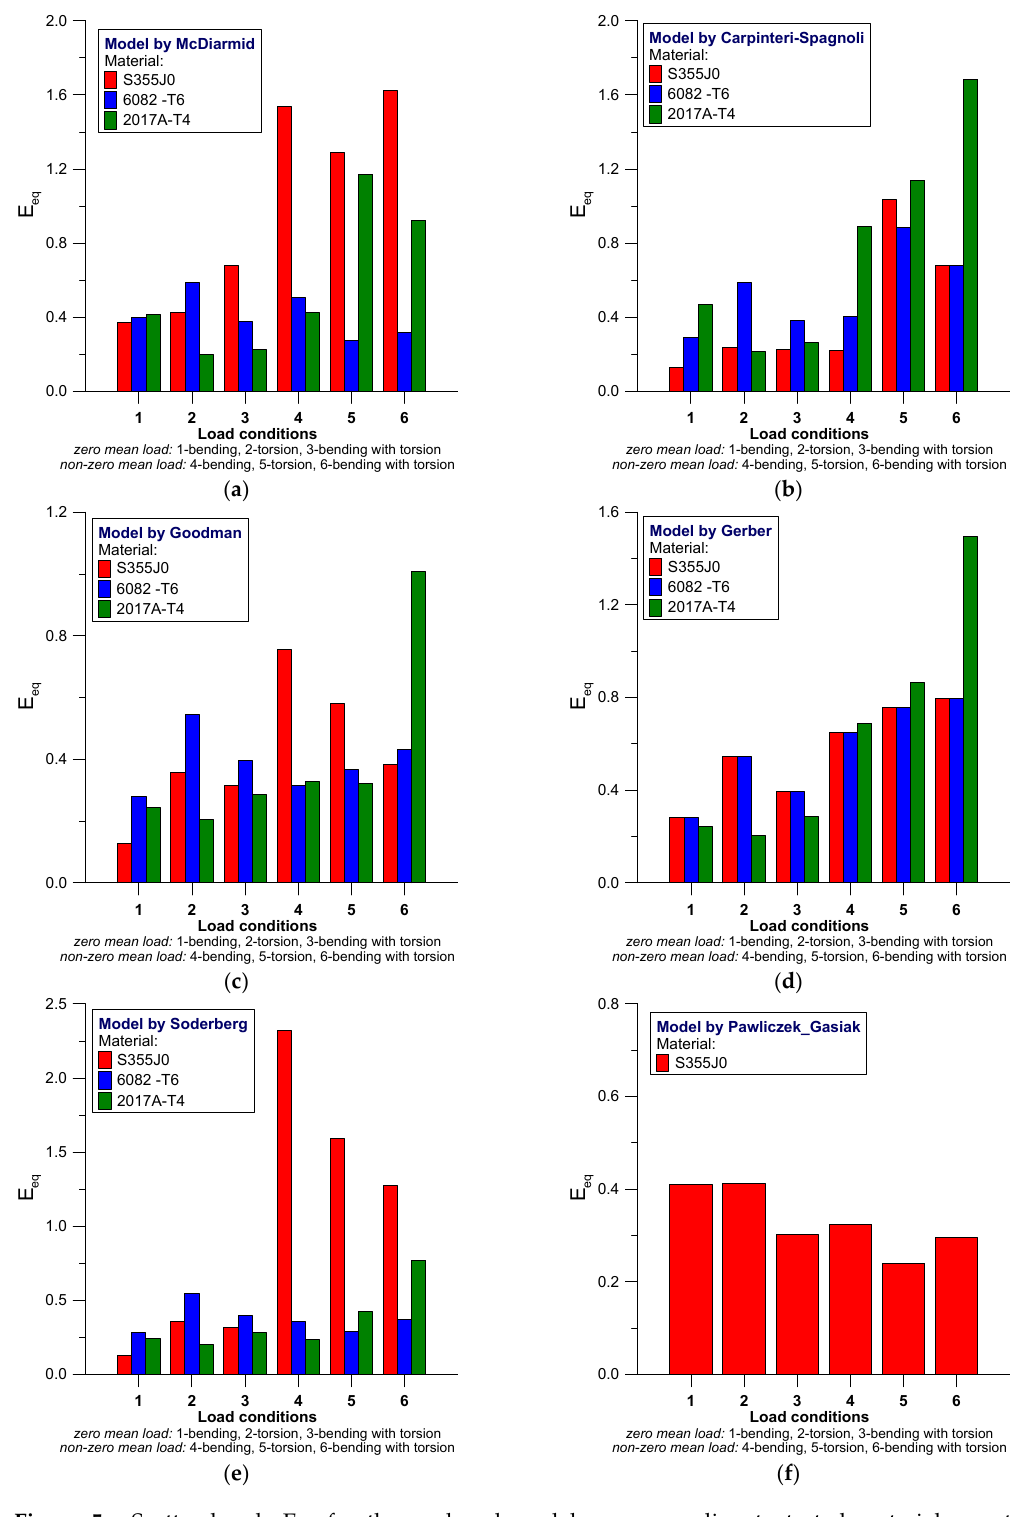
Figure 5. Scatter bands E eq for the analyzed models corresponding to tested materials, cont. ( a ) McDiarmid; ( b ) Carpinteri-Spagnoli; ( c ) Goodman; ( d ) Gerber; ( e ) Soderberg; ( f ) Pawliczek-Gasiak.